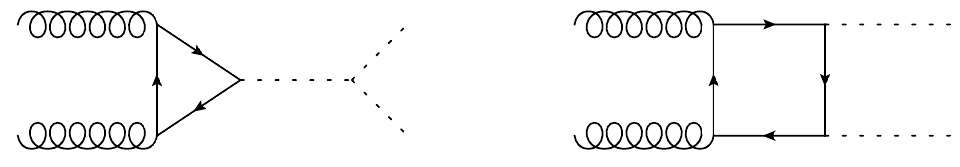
Figure 6 . Leading-order diagrams contributing to Higgs boson pair